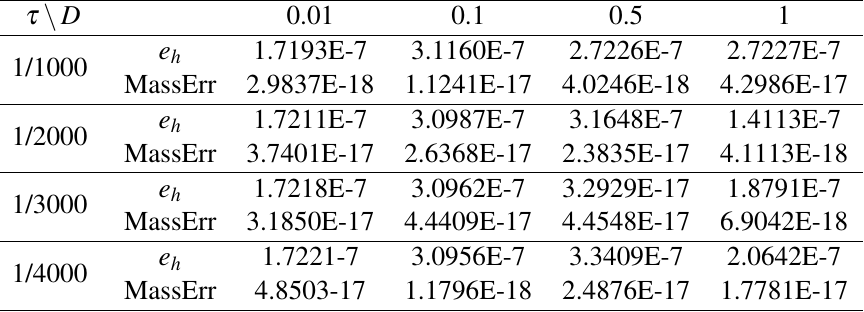
Table 3 Errors and mass errors for different diffusion D and different τ .